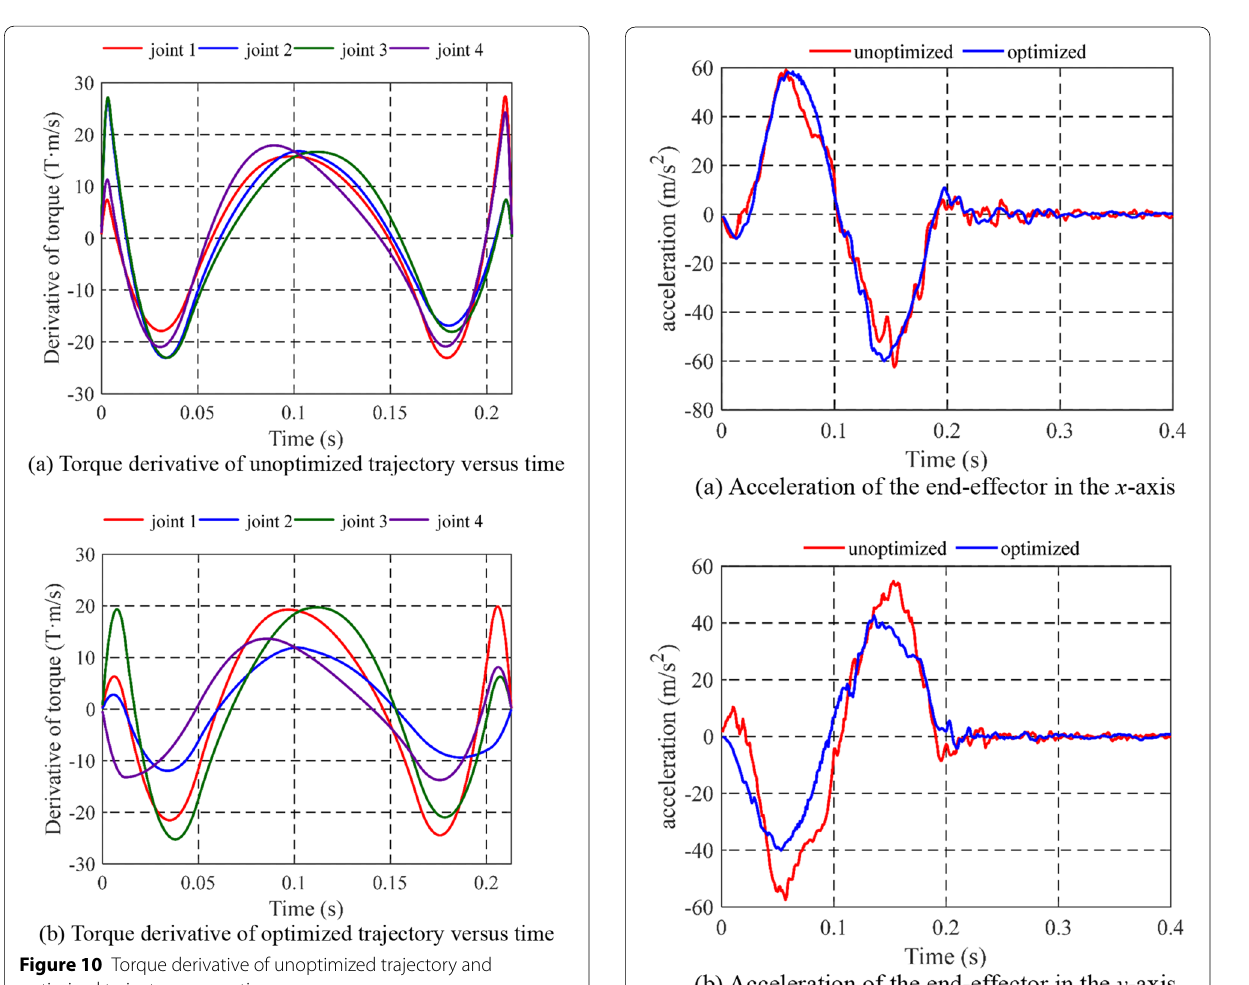
low lines stand for the edge parallel lines of the object at the placement time. In right frames, yellow dotted lines stand for the edge parallel lines of the ideal position of